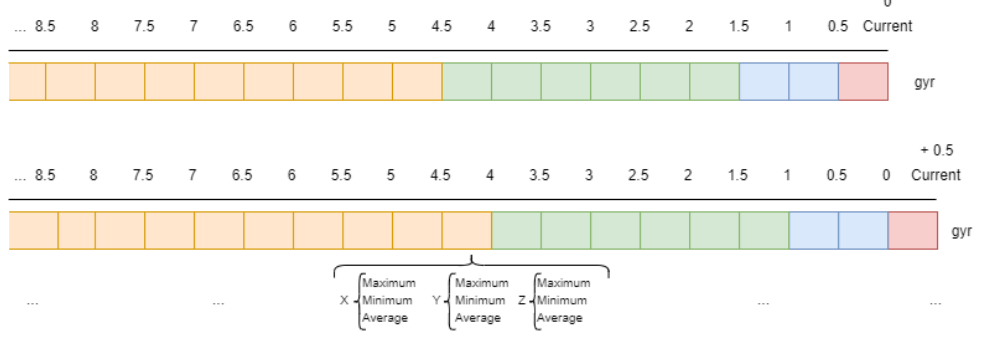
Figure 17. Metrics storage in Redis